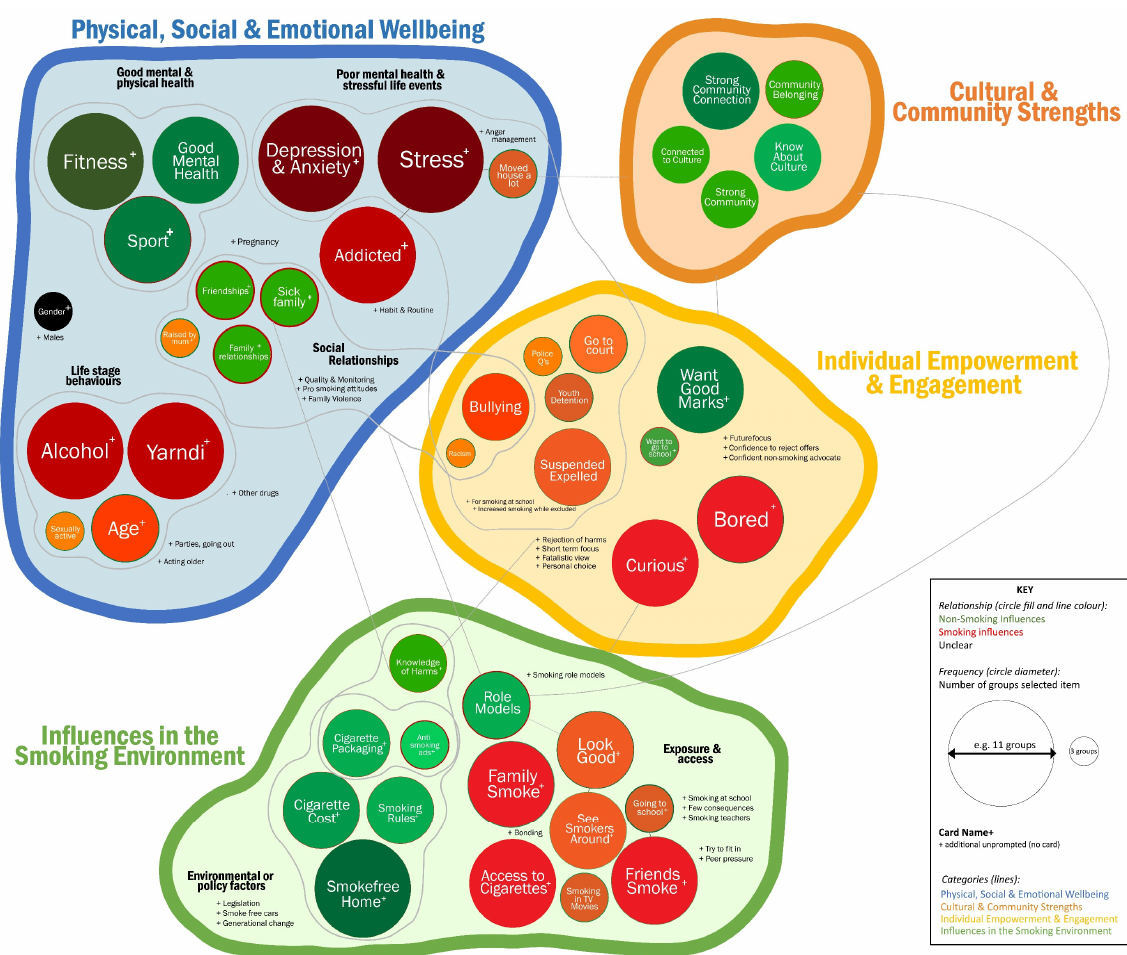
Figure 1. Concept map of the card sorting activity. This figure provides a visual summary of the grouping of key factors by theme and in relation to whether they were non-smoking (green) influences or smoking influences (red). The size of the circle reflects the number of groups that selected the card. A large-scale version is provided in Supplementary File S6.